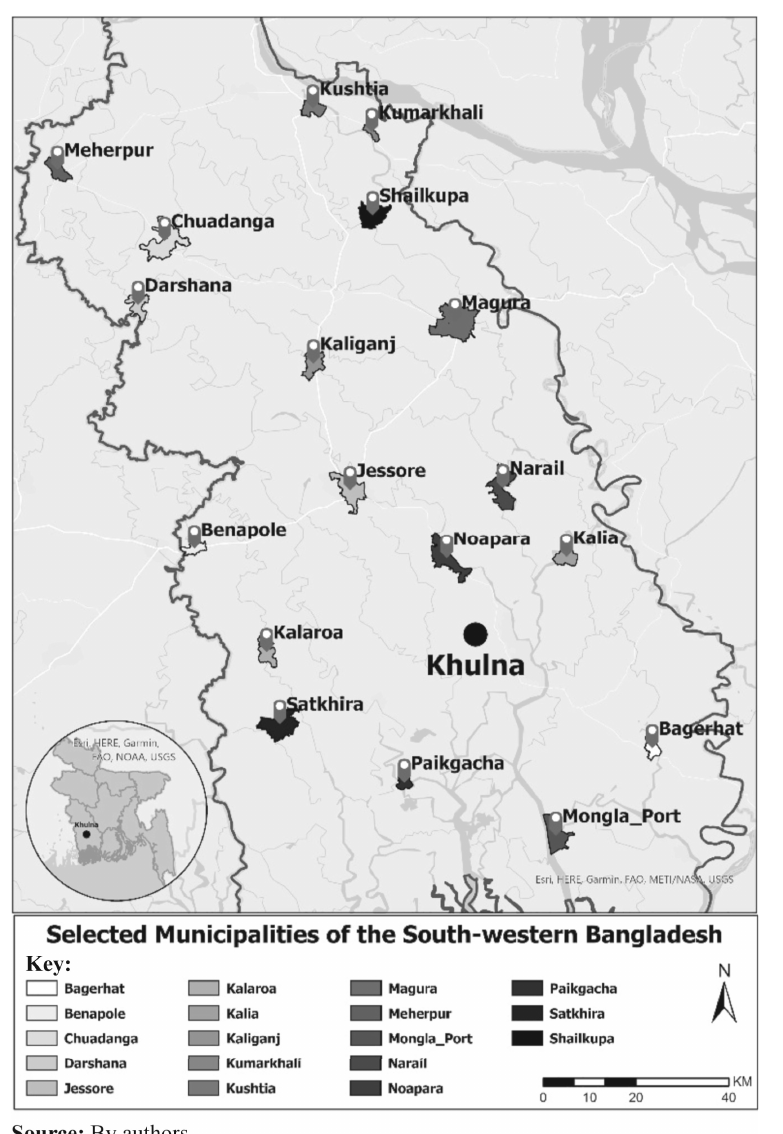
Figure 1. Map of the surveyed municipalities in the south-west region of